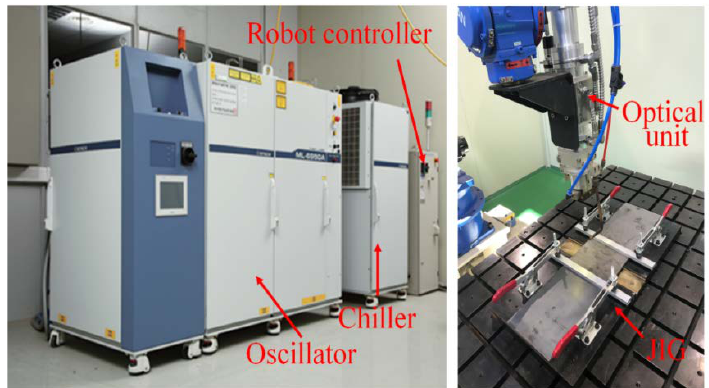
Figure 1. Fiber laser welding equipment.